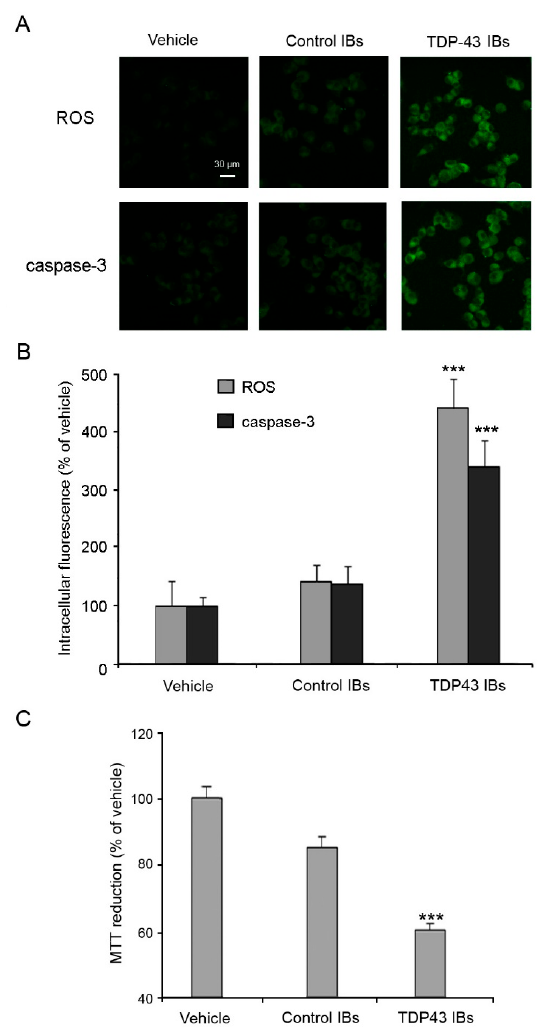
Figure 3. Analyses of intracellular ROS production, caspase-3 activation, and cell viability. ( A ) Representative confocal scanning microscope images of N2A cells showing intracellular ROS production and caspase-3 activation after transfection with vehicle, control IBs, and TDP-43 IBs. The green fluorescence arises from the CM-H 2 DCFDA probe that has reacted with ROS and from FAM-FLICA TM Caspase 3&7, respectively. ( B ) Quantitative analysis of the green fluorescence arising from CM-H 2 DCFDA and FAM-FLICA TM Caspase 3&7 probes. ( C ) MTT reduction of N2a cells transfected with vehicle, control IBs and, TDP-43 IBs and analyzed after 24 h. Error bars are S.D. *** p < 0.001 relative to cells transfected with vehicle.